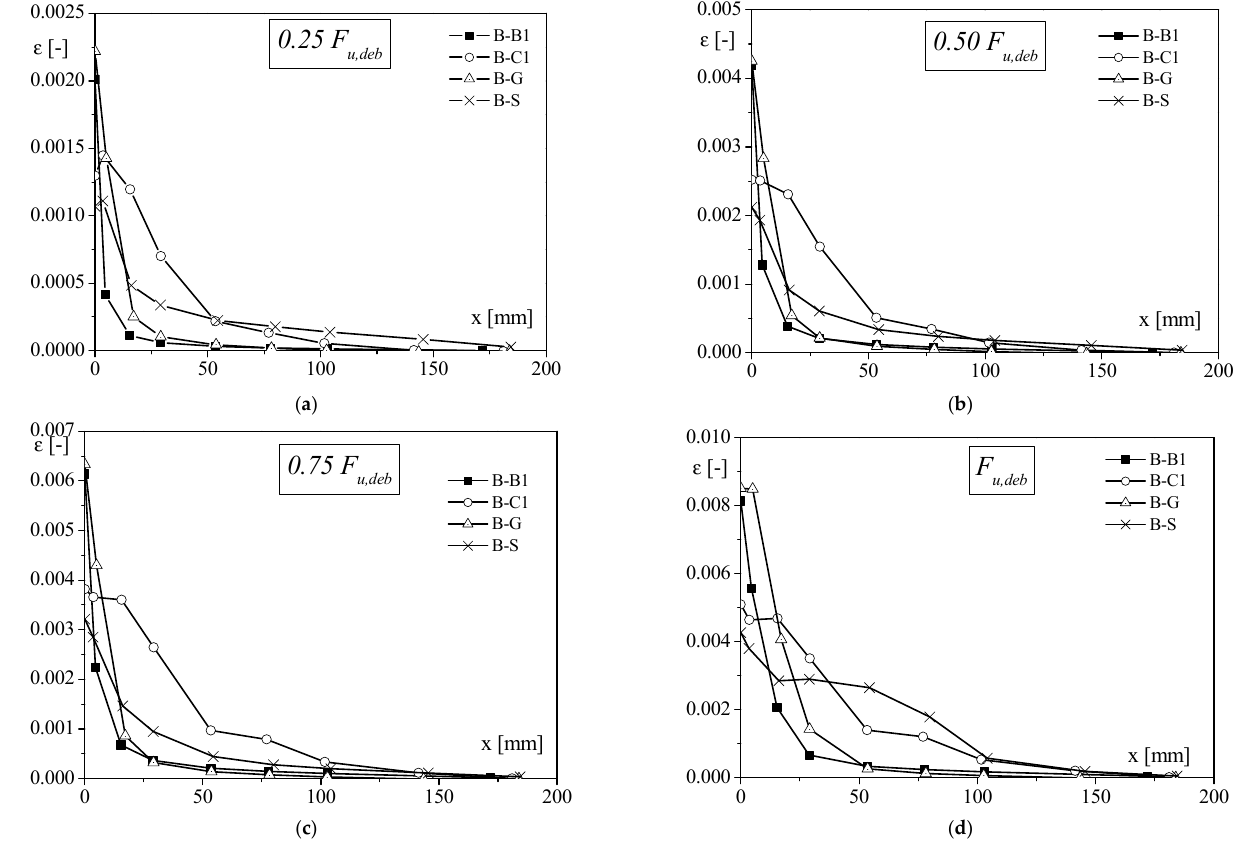
Figure 3. Comparison of strain distribution for specimens with clay unit substrate, varying the applied load: ( a ) F = 0.25F u,deb ; ( b ) F = 0.50F u,deb ; ( c ) F = 0.75F u,deb and ( d ) F = F u,deb .